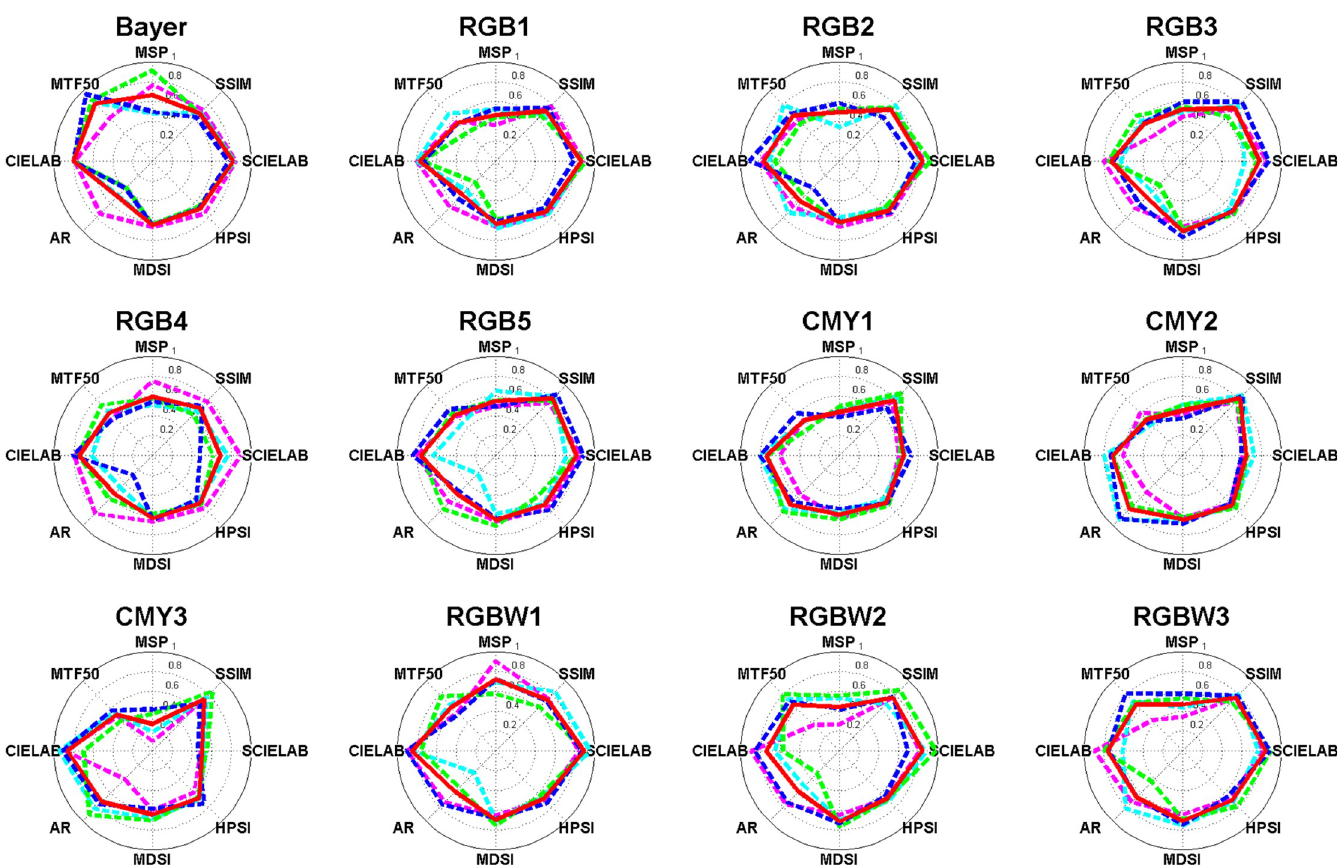
Fig 16. Polar coordinate visualization for test CFAs (magenta dotted line: Bilinear, cyon dotted line: laplacian, green dotted line: adaptive laplacian, blue dotted line: POCS, and red solid line: average).